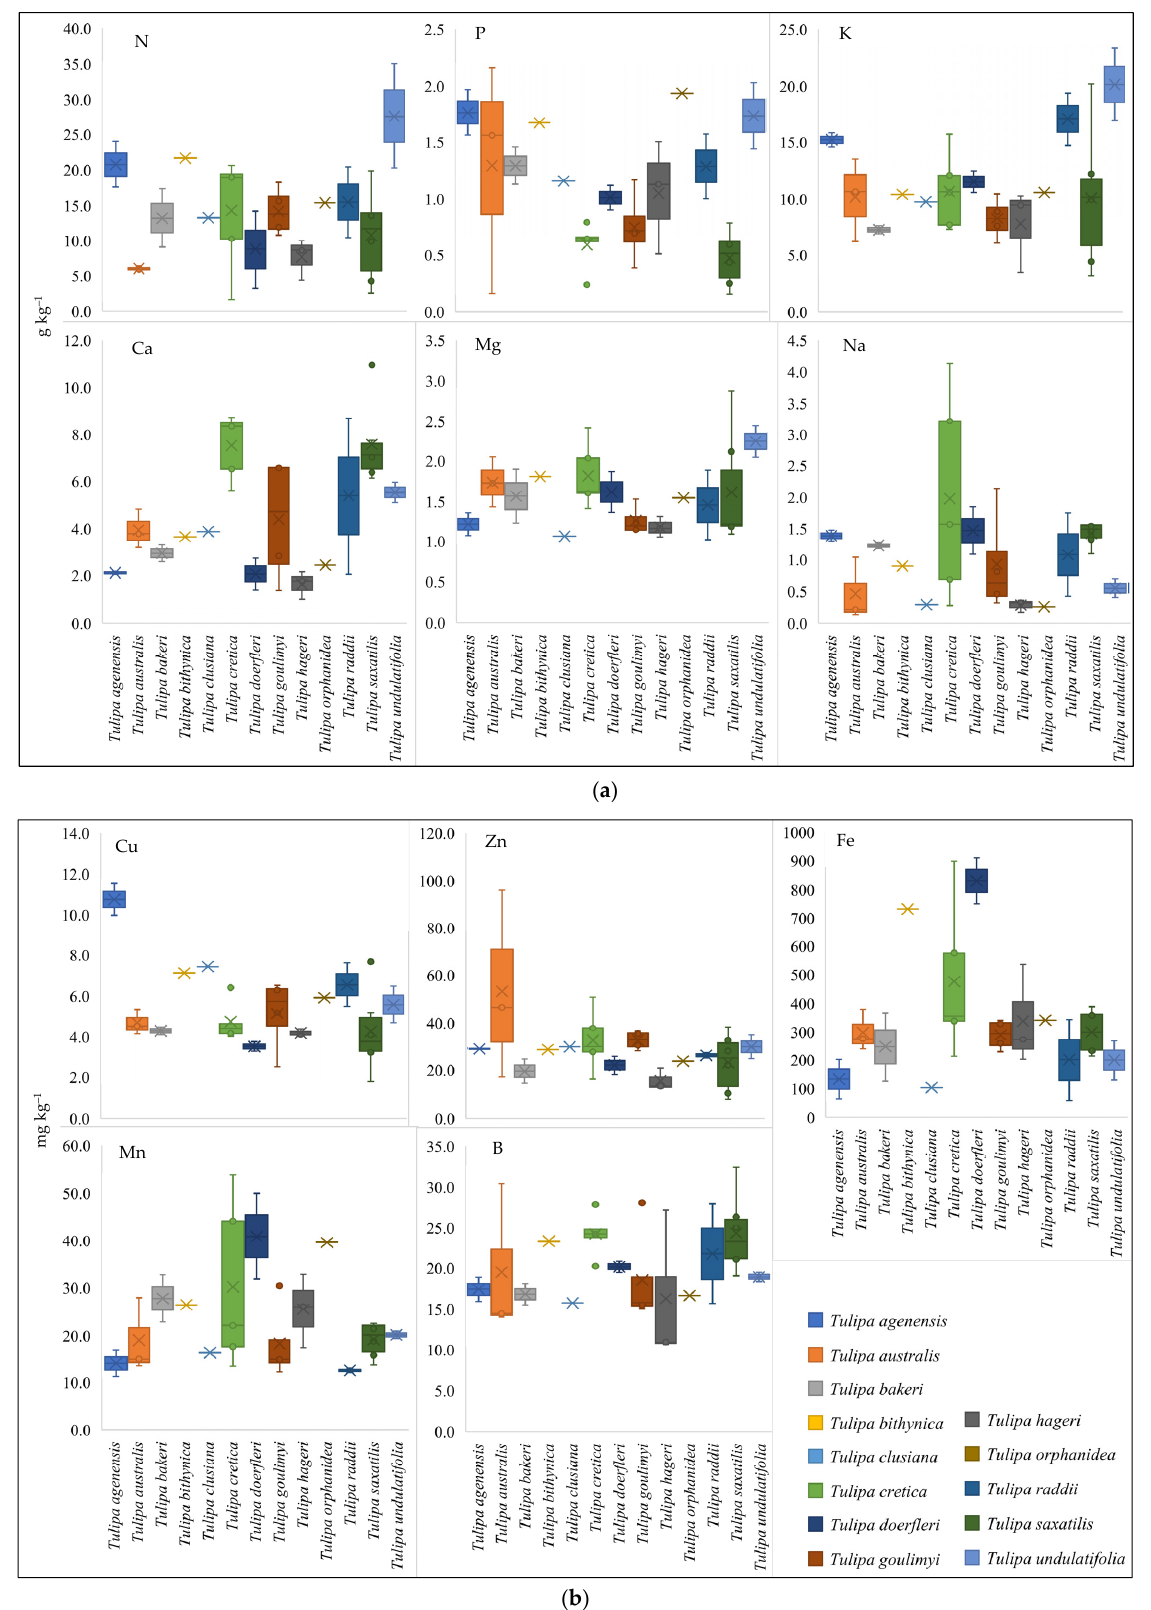
Figure 3 . Boxplots showing concentrations of ( a ) macro-nutrients (N, P, K, Ca, and Mg) and beneficial element Na, and ( b ) micro-nutrients (Cu, Zn, Fe, Mn, and B) in above-ground biomass of wild-growing Greek tulip species. Box colors represent different Tulipa species.